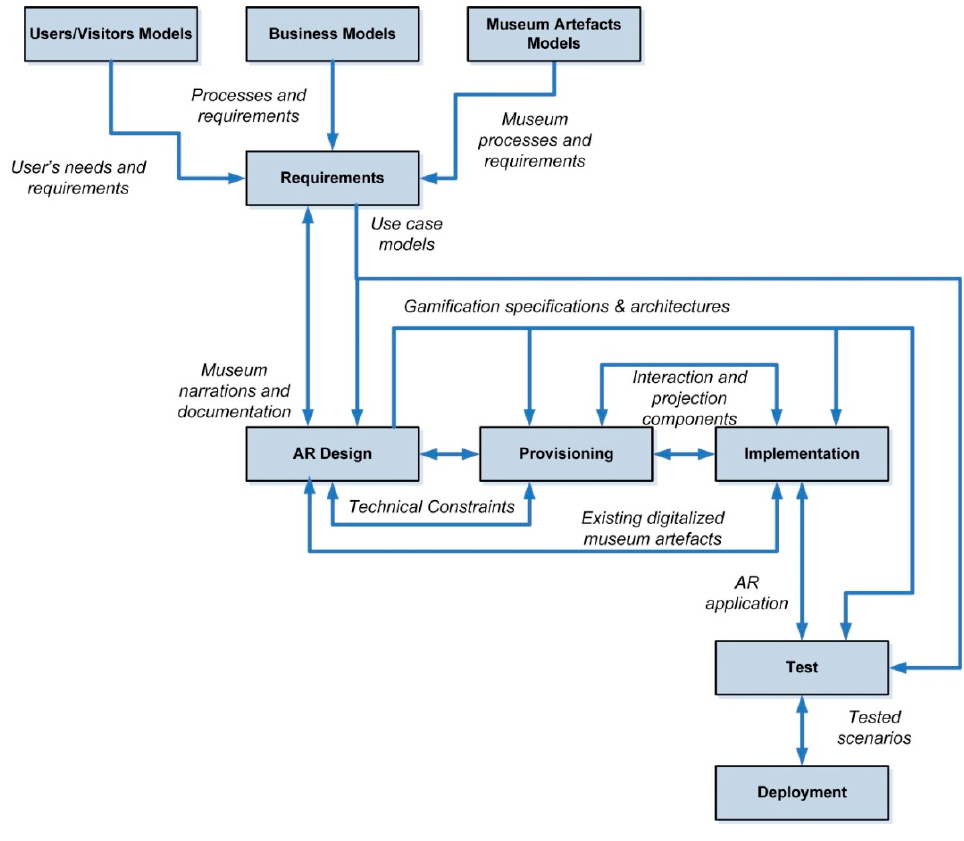
Figure 5. Overall AR development process.